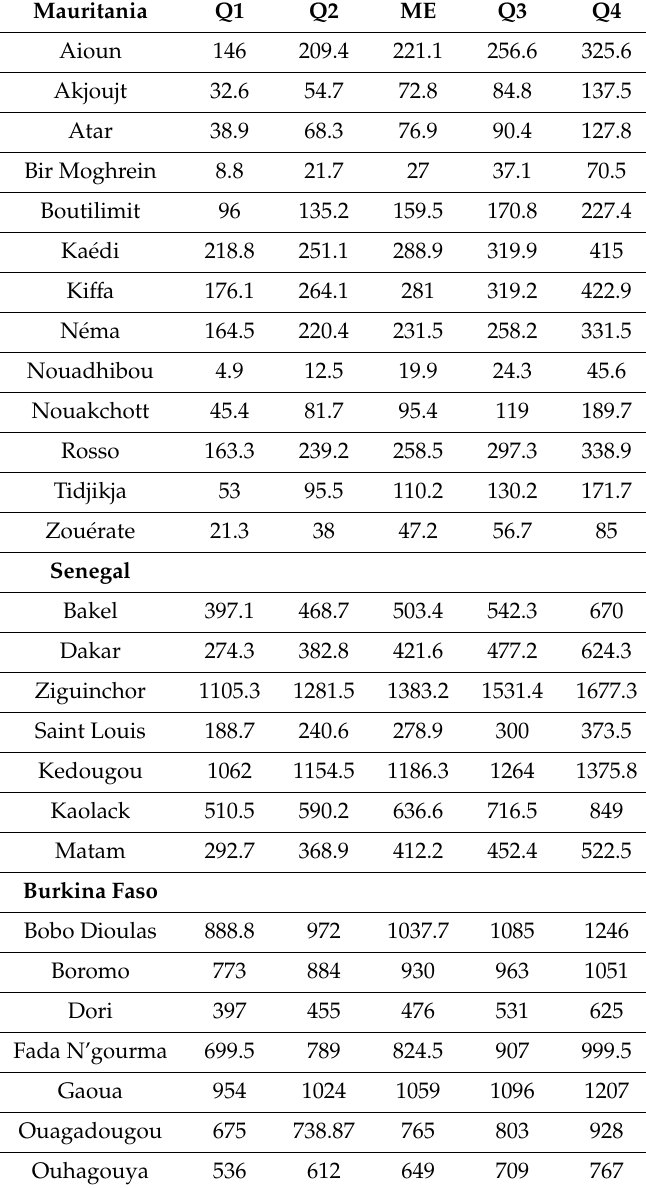
Table 1. Distribution and hierarchization of annual rainfall according to the